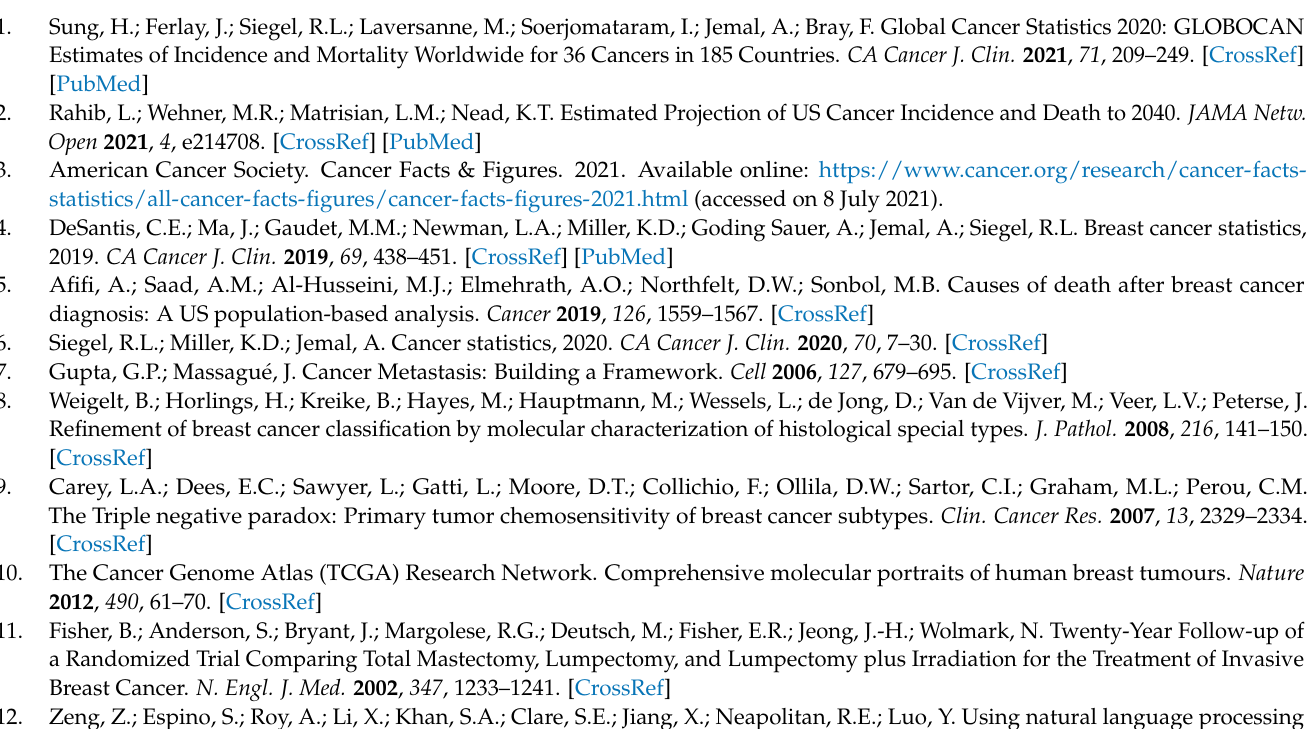
Table S2: Description of the ML hyperparameters and Their Values Tested. Table S3: Significance test results: one-tailed (greater) Wilcoxon rank sum tests. Table S4: Significance test results: one-tailed (less) Wilcoxon rank sum